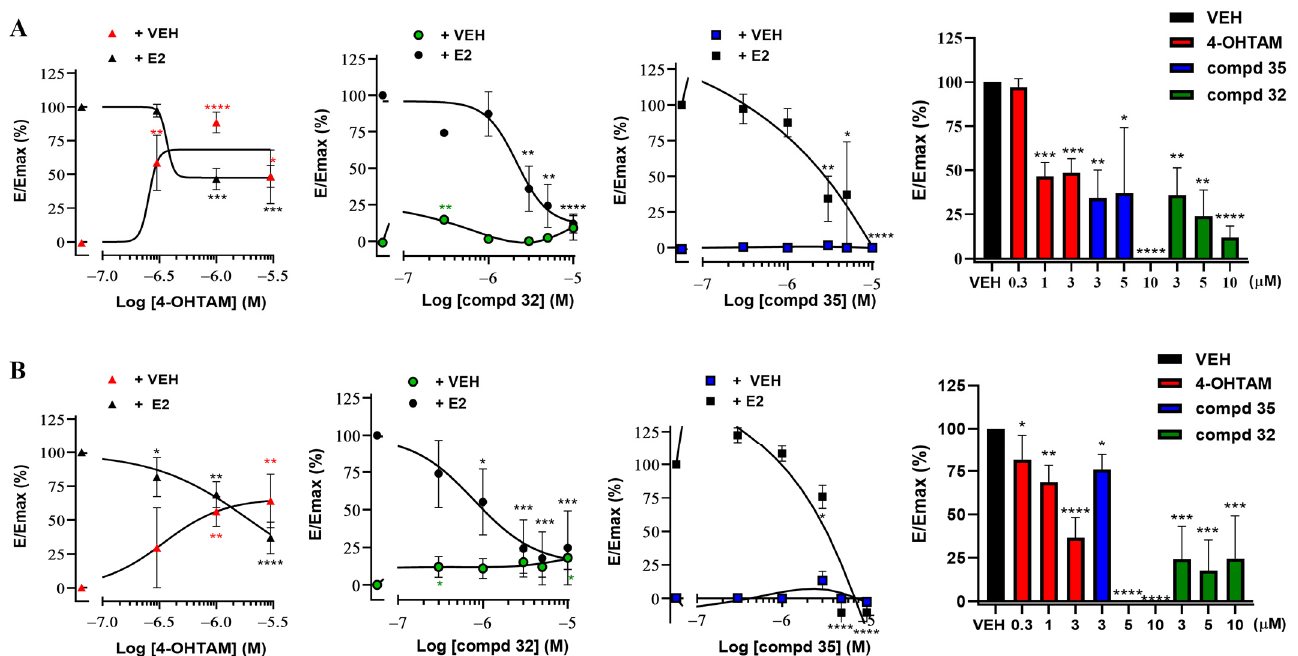
Figure 11. 5-Hydroxy-2 H -pyrrol-2-ones 32 and 35 exhibit antagonistic effects on E2-induced alkaline phosphatase enzymatic activity (ALP) in a time and dose dependent-manner in ER+ endometrial cancer cells. E2-depleted Ishikawa cells were treated with vehicle (VEH, 0.05% DMSO), 4-OHT (0.3– 3 µM), compounds 32 or 35 (both, 0.3–10 µM) in the absence (+VEH) or presence of E2 (10 nM) for ( A ) 48 h and ( B ) 72 h. The left panels show dose-response curves of the studied compounds, which are represented by plotting the decimal logarithm of the concentration of the compound against the E/Emax (%), calculated from the Emax induced with E2. Doses of compounds in the absence of E2 (+VEH) are shown as ▲ for 4-OHTAM, ● for compound 32 , and ∎ for compound 35 , while doses of products + E2 (10 nM) are represented as ▲ , ● , ∎ , respectively. The right panels represent bar diagrams of the E/Emax (%) of compound doses + E2 (10 nM), calculated from the Emax (100%) induced by E2 after the corresponding treatments and times. Statistical significance was assessed using one-way ANOVA with Bonferroni post hoc test using GraphPad Prism software 8.4.3. * p < 0.05; ** p < 0.01; *** p < 0.001; **** p < 0.0001 versus E2-stimulated cells. Data are expressed as mean ± SEM for at least two independent experiments, where each treatment was tested in